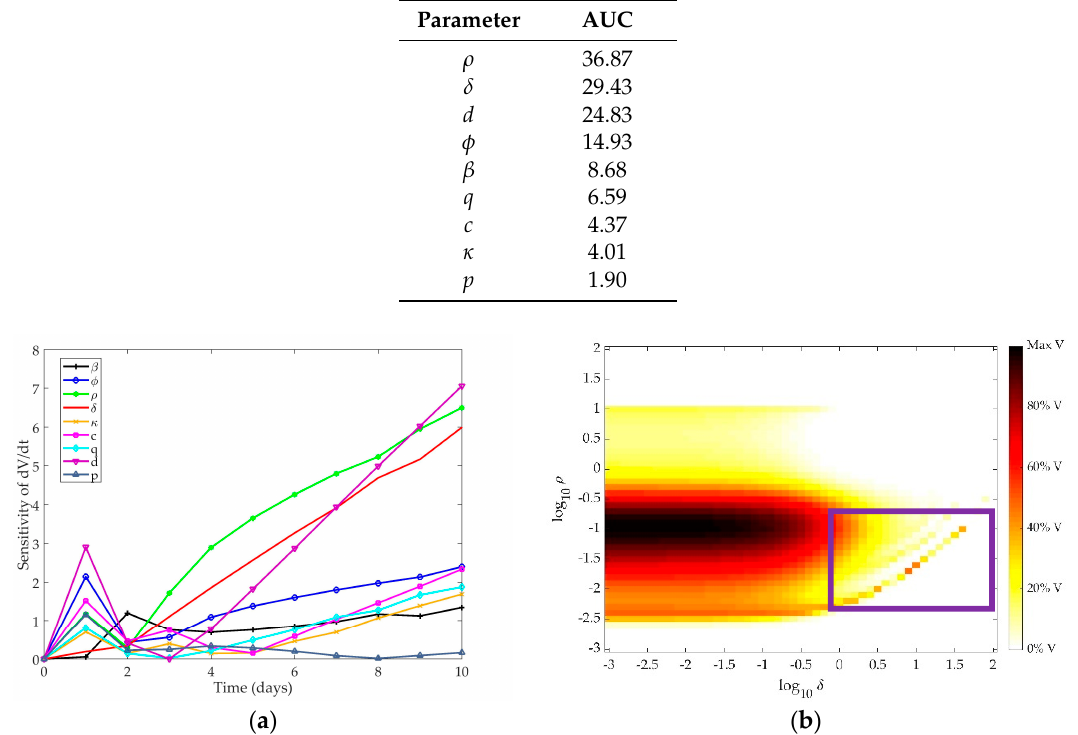
Table 1. Area under the curve (AUC) of virus equation for each parameter in the Pawelek model.